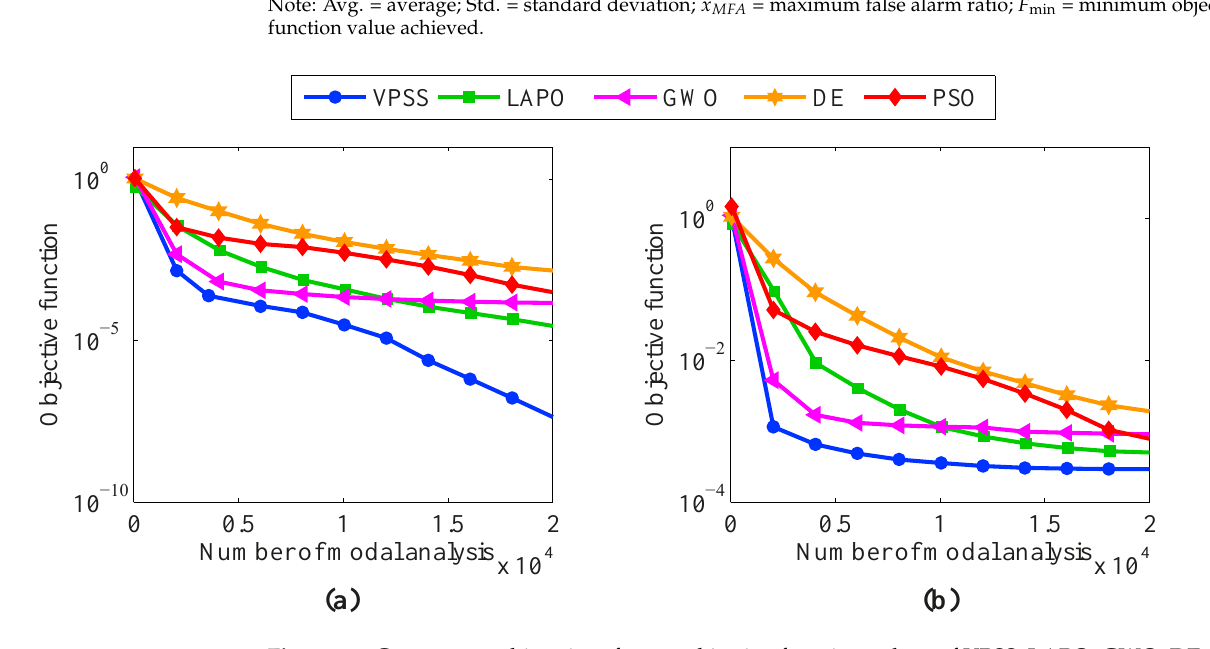
Figure 11. A two-bay three-story frame. Figure 12 demonstrates the average identification results achieved by VPSS, LAPO, GWO, DE, and PSO in both the noise-free and noisy conditions. Additionally, Table 5 summarizes details about the average values, standard deviations, and the maximum